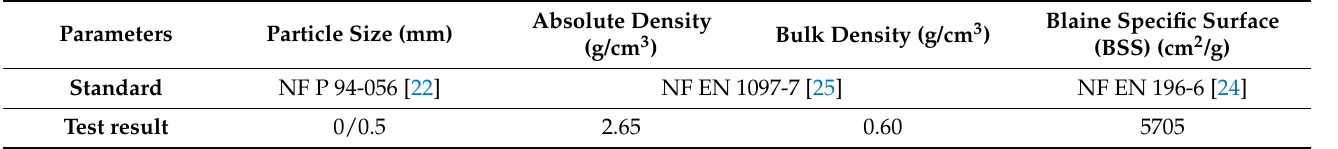
Table 2. Physical properties of gypsum